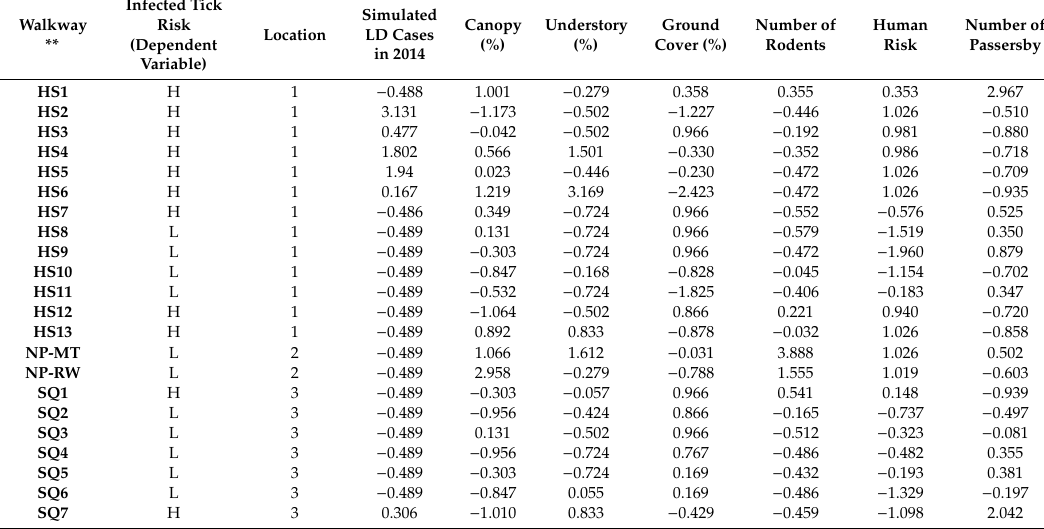
Table 2. Standardized data for walkways—infected tick risk is coded to account for high (H) and low (L) risk of exposure to infected ticks in each walkway—Hillside walkways are coded as 1, Nature Preserve walkways are coded as 2, and Susquehanna walkways are coded as